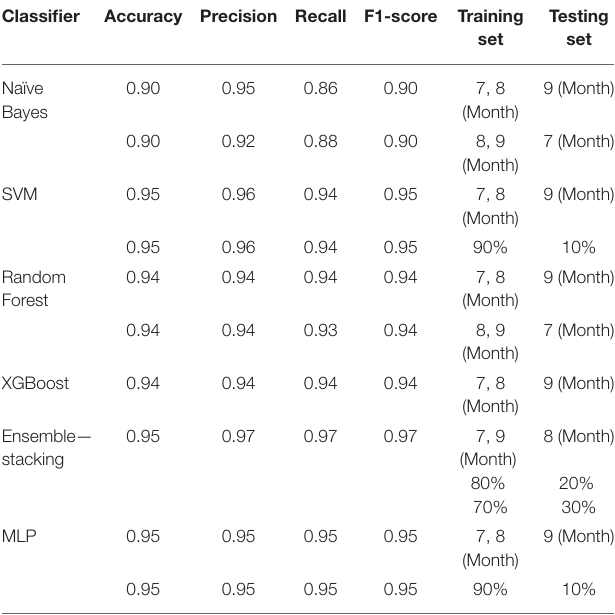
TABLE 4 | Best performance achieved for each classifier—evaluation